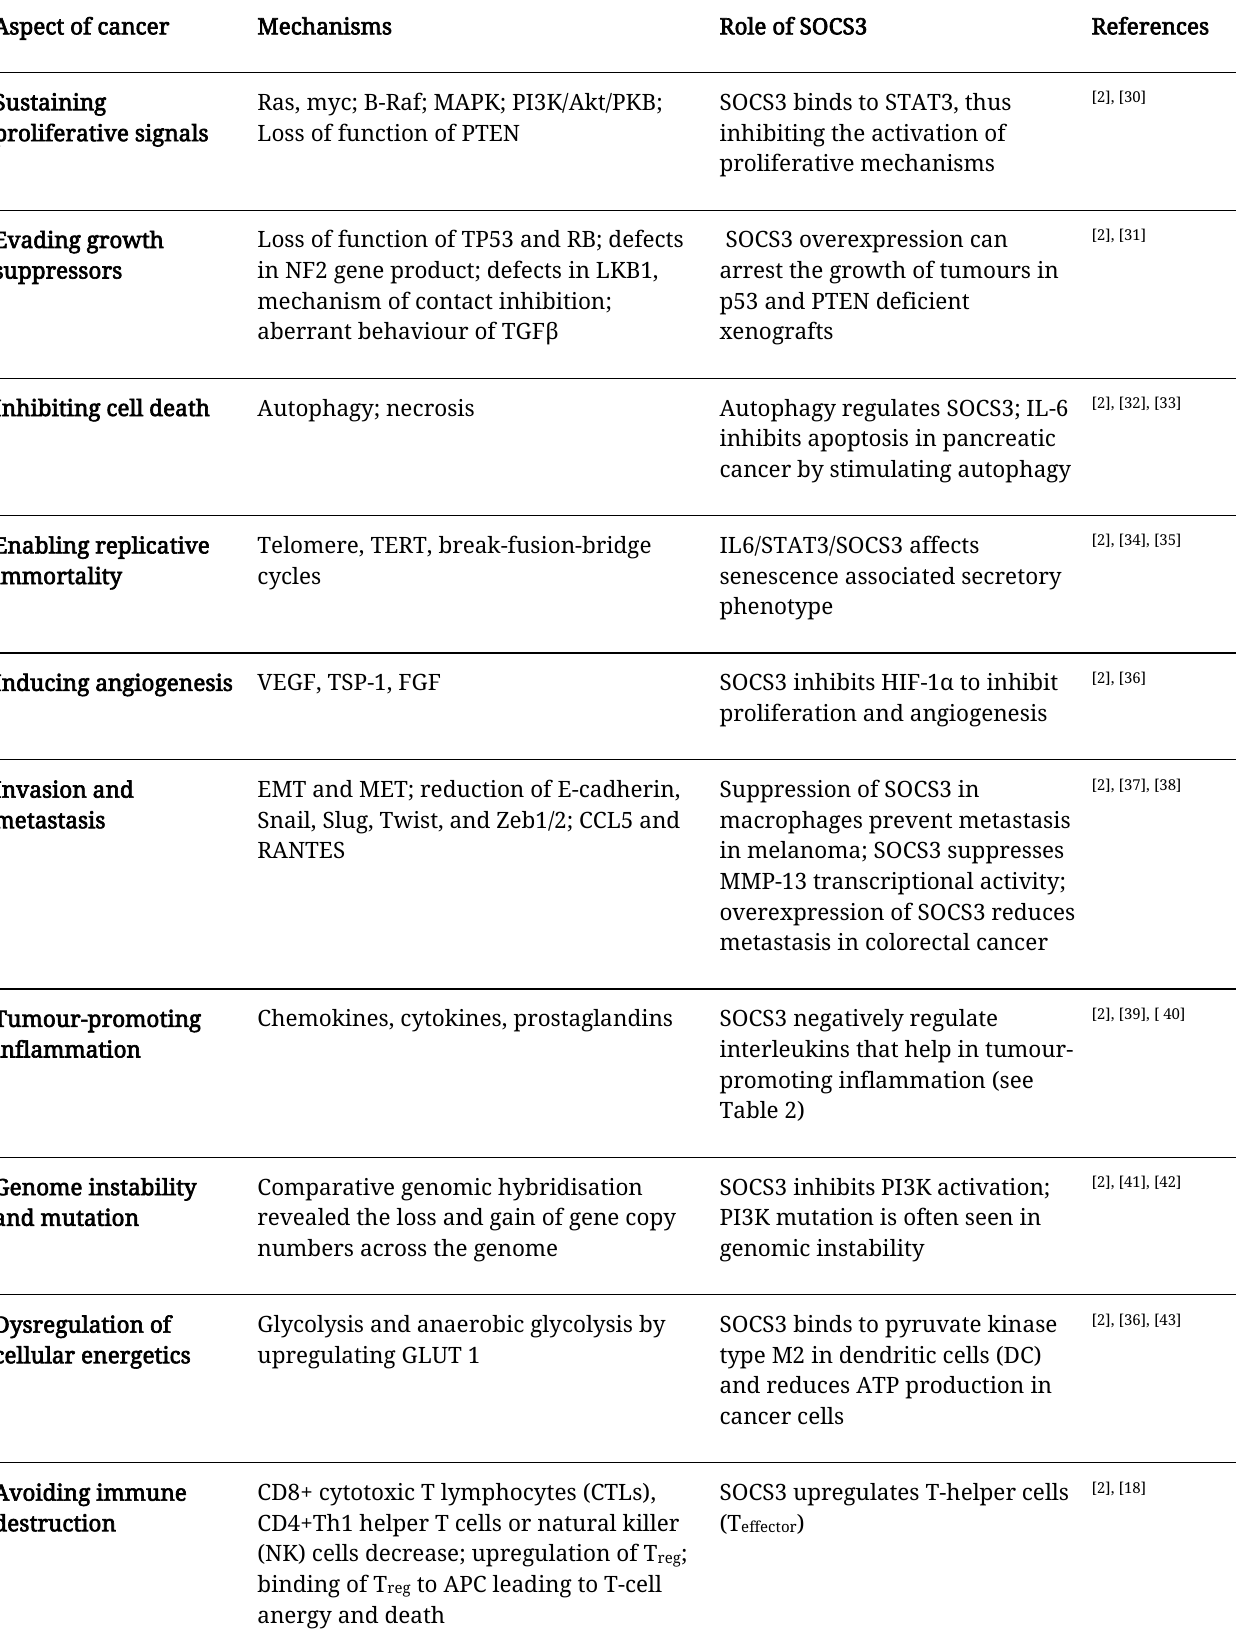
Table 1: SOCS3 affecting different hallmarks of cancer Aspect of